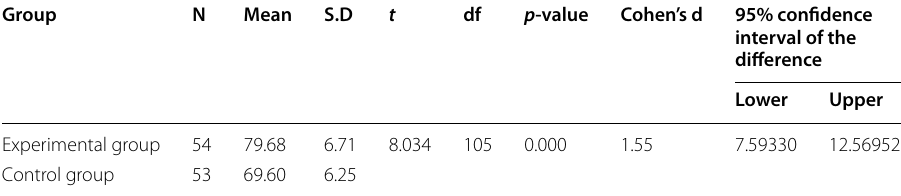
Table 3 t-test analysis of Post-test of student’s academic achievement levels Group N Mean